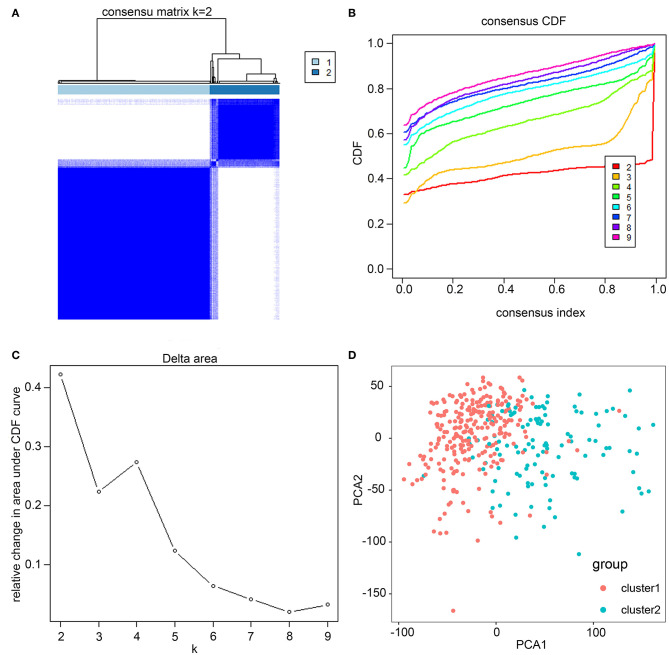
Consistent cluster analysis of HCC. (A) The correlation between subgroups when cluster numbers k = 2. (B) Cumulative distribution function (CDF) is displayed for k = 2–9. (C) The relative change in area under the CDF curve for k = 2–9. (D) Principal component analysis of the RNA-seq data. Red dots represent cluster 1 and cyan dots represent cluster 2.